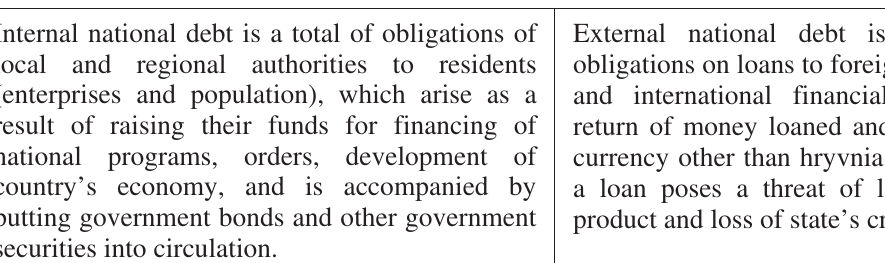
Fig. 1. The essense of national debt and its main components